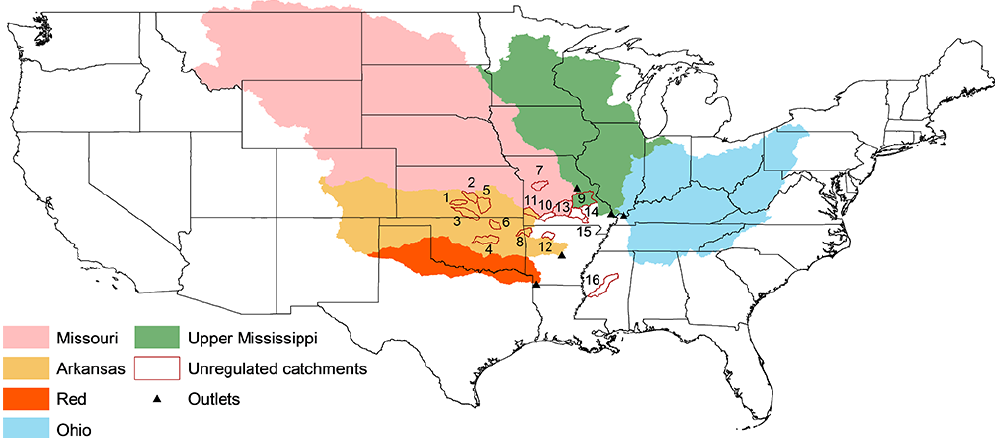
Figure 1. Map of the 5 large-scale basins (color shading – see Table 1) and 16 unregulated medium-scale basins (red outlines – see Table 2) considered in the analysis. Table 1. Attributes of large-scale basins in Fig. 1. River basin USGS station USGS station